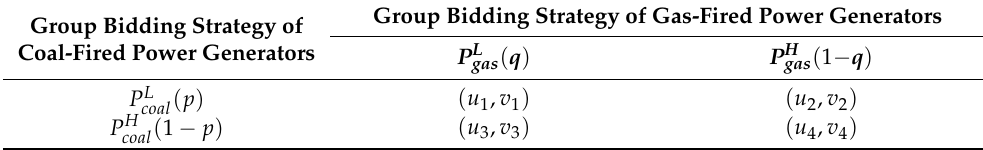
Table 1. Power market operation situation system dynamics model module